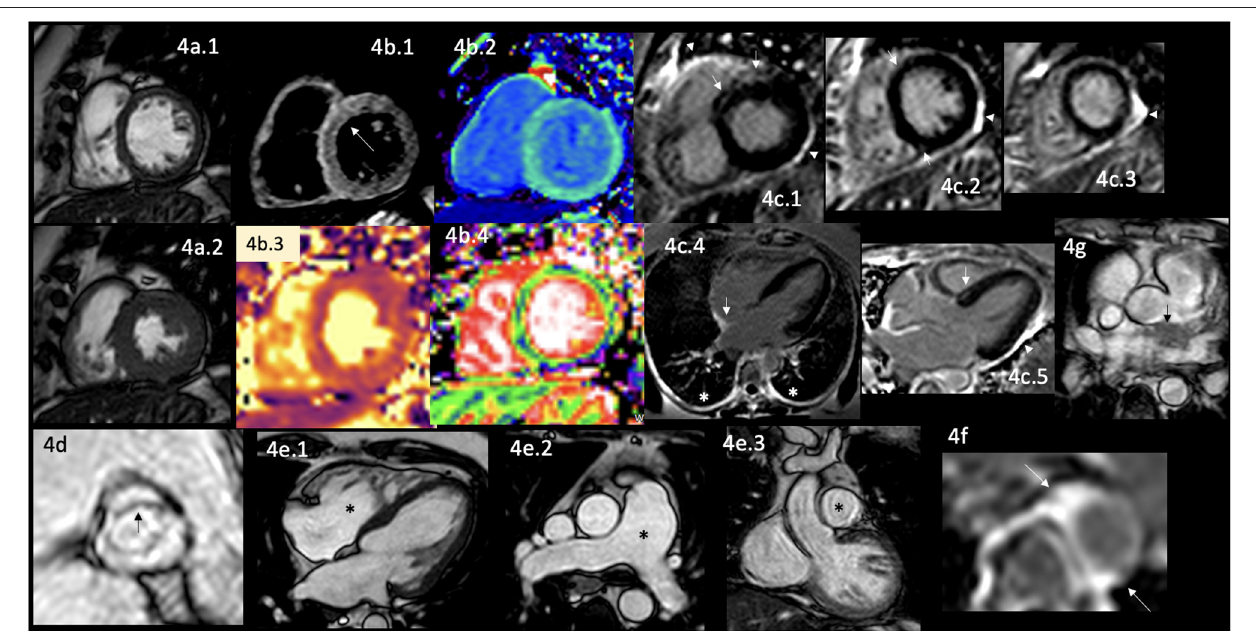
FIGURE 4 | CMR findings in AR. A panel figure demonstrates varying findings from a comprehensive CMR study at a 3.0 Tesla scanner of RA with PH and arrhythmias. (a) SSFP sequence still cine images in short-axis view at the mid-ventricular level in end-diastole (a.1) and in end-systole (a.2) show normal global and regional left ventricular functions, mass, and wall thickness, LVEF 64% and moderately reduced systolic global RV function with global hypokinesia and mild hypertrophy (RV mass index 95 g/m 2 ), RVEF 44%. (b.1) T2-W STIR sequence in short-axis view at a mid-ventricular level showing mildly increased signal intensity in the anterior, anteroseptal, and inferoseptal segments (arrow) with a myocardial/skeletal muscle ratio of 2.4 suggesting mild myocardial edema. (b.2) T1 mapping with a native T1 of 1,212ms (normal), (b.3) T2 mapping with a T2 time of 42 msec (upper limit of normal) and (b.4) the ECV map corresponding to an elevated 52%. (c) LGE PSIR sequence. (c.1–3) Short-axis views at basal (c.1) , mid (c.2) , and apical (c.3) levels, and long-axis views in four-chambers (c.4) and three-chambers (c.5) projections. The arrows in these images show areas of focal fibrosis as midventricular LGE in the anteroseptal segment in (c.1,2) and the subepicardium of the anterior segment in (c.1) and subepicardial in the inferior segment in (c.2). (c.4) Shows LGE on the upper RA wall (arrow) and both-sided pleura (asterisks). (c.5) Shows mid-wall LGE on the anteroseptal segment. Pericardial LGE is shown in (c.1–3,5) (arrowheads), consistent with pericardial inflammation in the absence